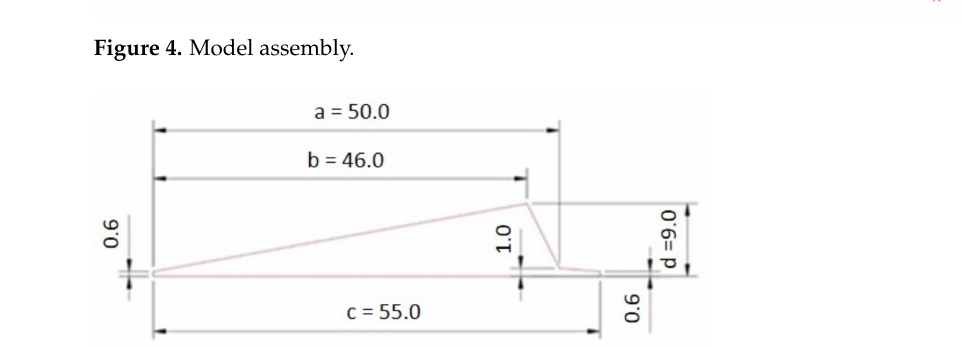
Figure 5. Dimensions of apex before